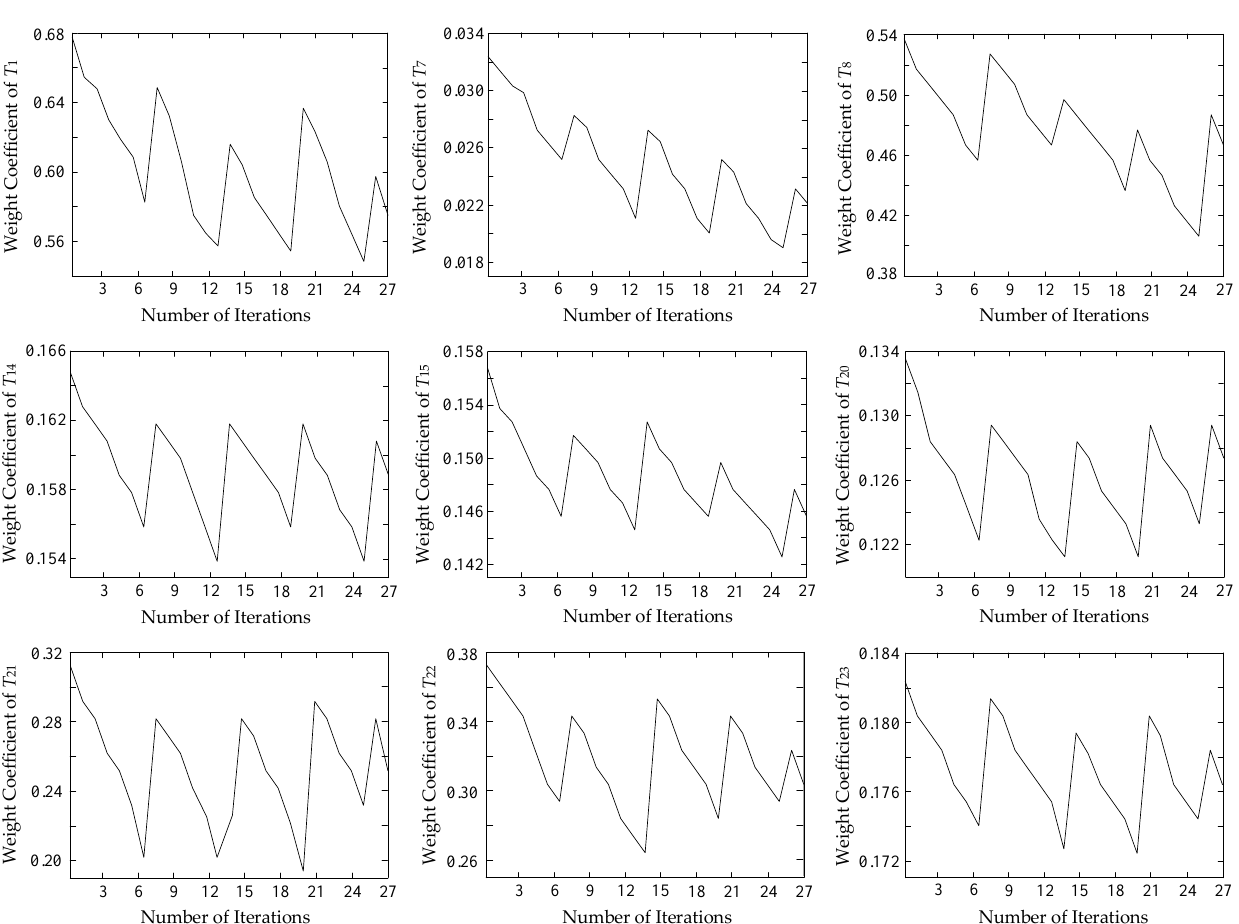
Figure A1. Results of the weight coefficients of optimal features.